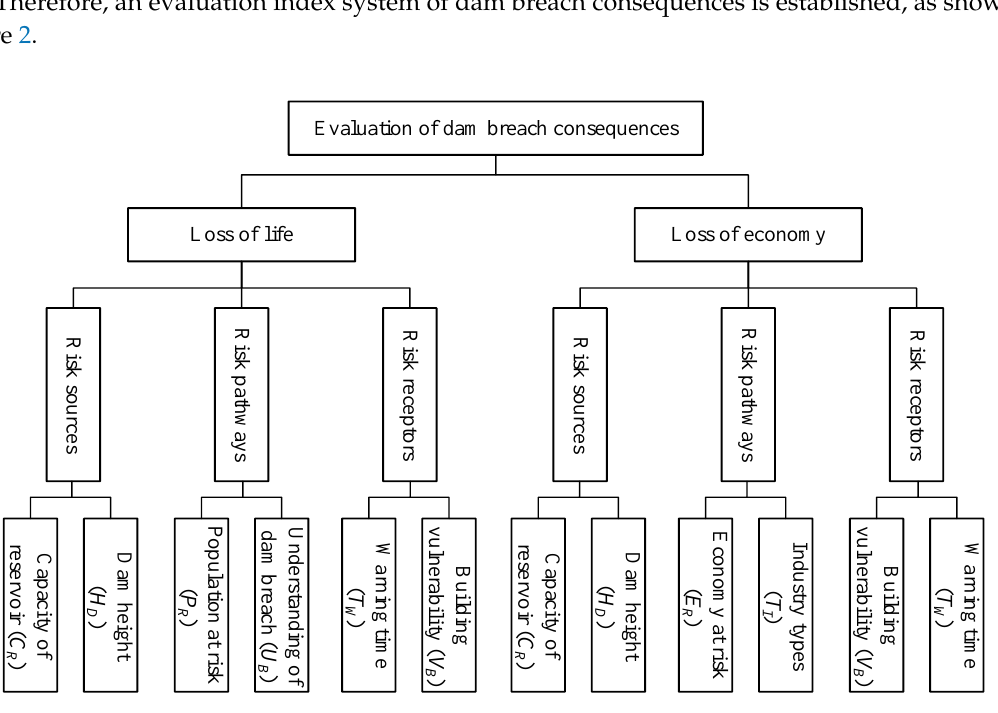
Figure 2. Evaluation index system of dam breach consequences.